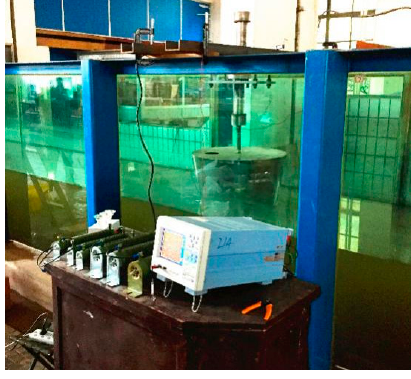
Figure 17. The experiments on the MI-TLPMG in the wave tank.